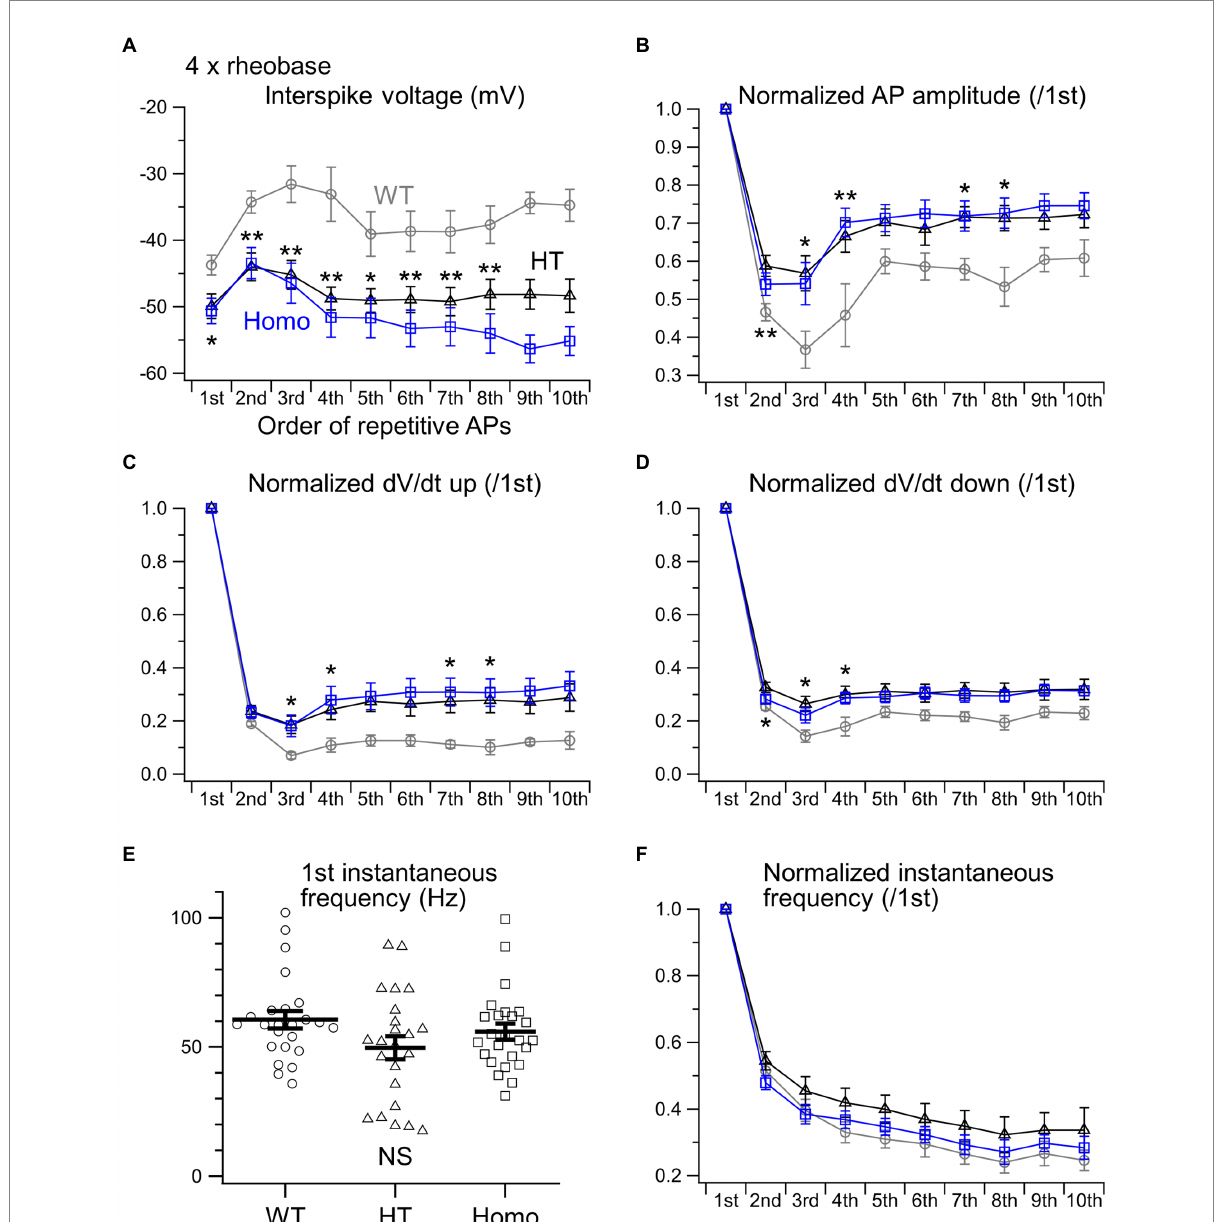
FIGURE 5 Properties of repetitive AP firing induced by 4 × rheobase. (A) The initial 10 interspike voltage levels were compared between WT (gray), HT (black) and Homo (blue) neurons. (B) Normalized AP amplitudes of the initial 10 APs. (C) Normalized dV/dt ups. (D) Normalized dV/dt downs. * p < 0.05, ** p < 0.01, WT vs. HT and Homo by REGW-F. (E) The first instantaneous frequency. Symbols indicate the values in individual neurons, and thick bars with error bars indicate means ± SEMs. WT: 60.6 ± 3.4 Hz, HT: 49.7 ± 4.5 Hz, Homo: 55.9 ± 3.1 Hz, p = 0.220 by K-W. NS, not significant. (F) The initial 10 instantaneous frequencies were normalized to the first. (A–D,F) The parameters of the 9th and 10th APs were not compared statistically, because the number of spikes induced by 4 × rheobase in WT neurons was so small (4.7 ± 0.8 spikes/s) that the sample sizes of the 9th and 10th APs in WT neurons were less than